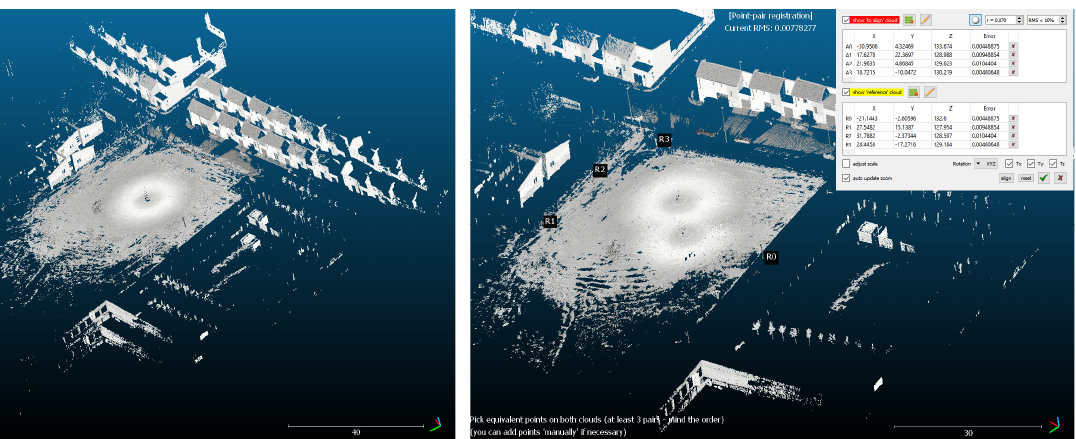
Figure 6. ( Left ): Two unaligned clouds of data points. ( Right ): The two clouds of data points aligned via the use of four reference spheres.